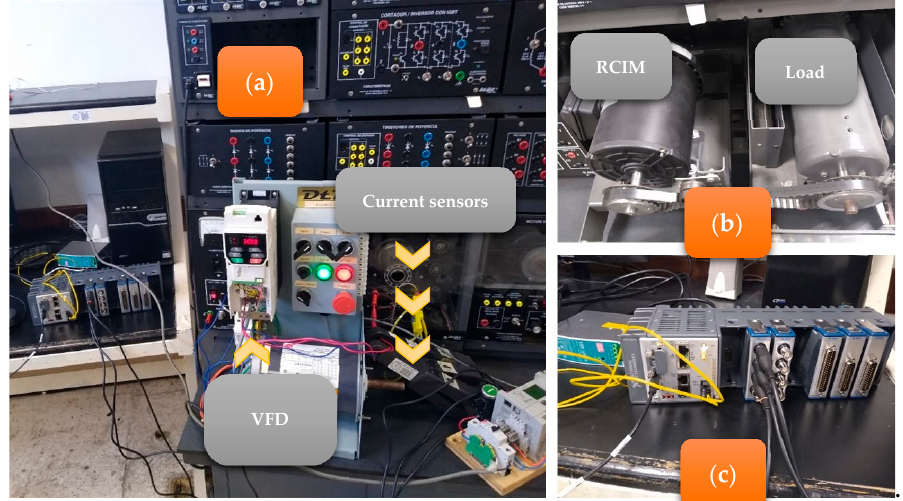
Figure 5. Laboratory test system. ( a ) Full system. ( b ) RCIM under analysis and its load. ( c ) National Instruments data acquisition system compact RIO.